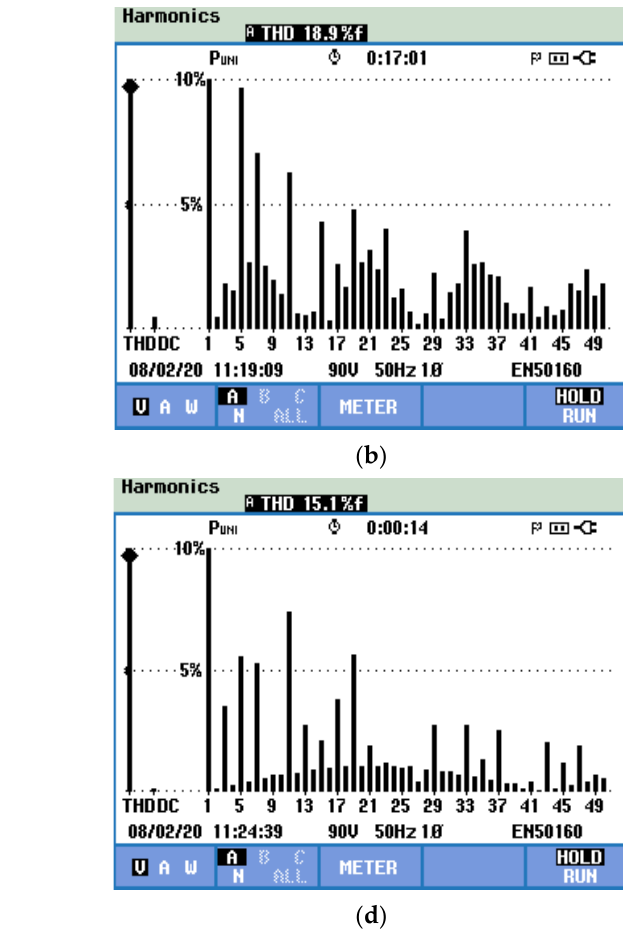
Figure 16. Hardware result of the Quasi-linear MLI for 3rd order harmonic elimination using: ( a ) the conventional technique; ( b ) THD analysis of the conventional technique; ( c ) the proposed tech- nique; and ( d ) THD analysis of the proposed technique.